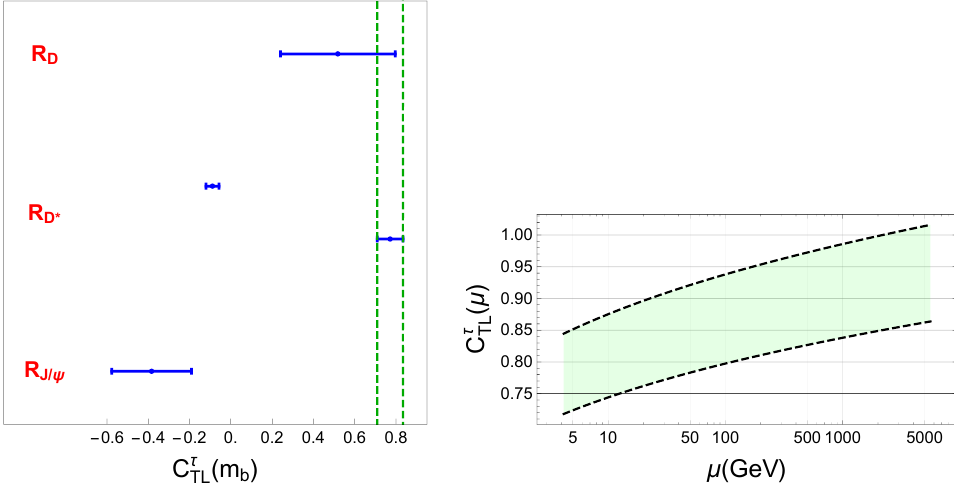
Figure 3 . Left panel : the horizontal lines correspond to the values of C (cid:28) mental measurement of R D , R D (cid:3) and R that explains R D and R D (cid:3) simultaneously. Right panel : renormalisation group running of C (cid:28)